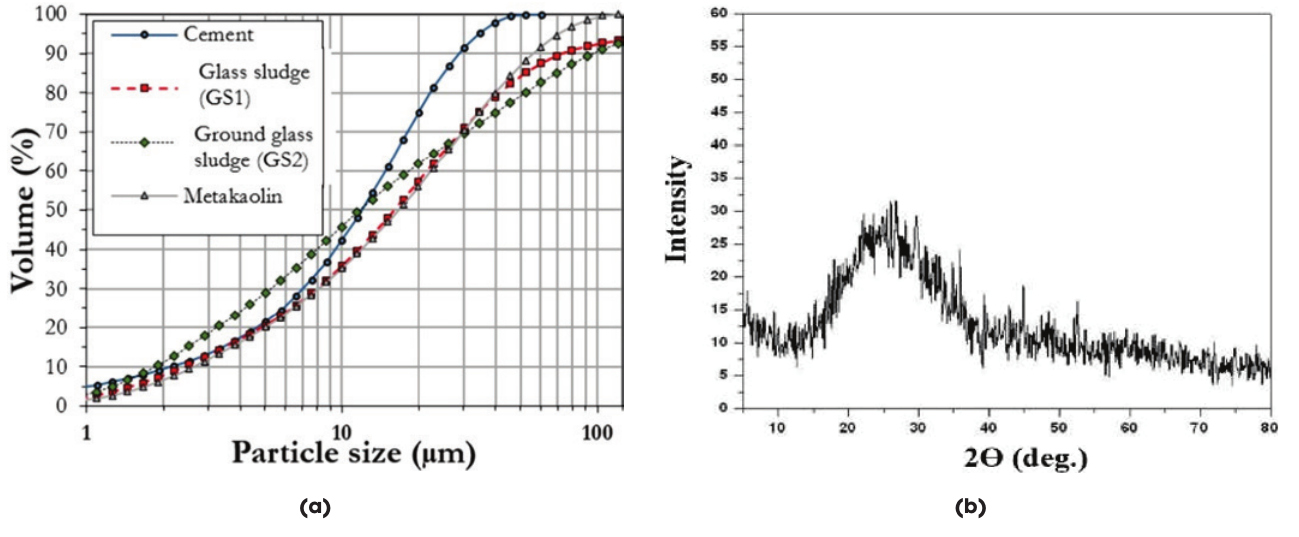
(a) Size gradation curve of cement, GS1, GS2 and metakaolin. (b) X-ray diffraction (XRF) of